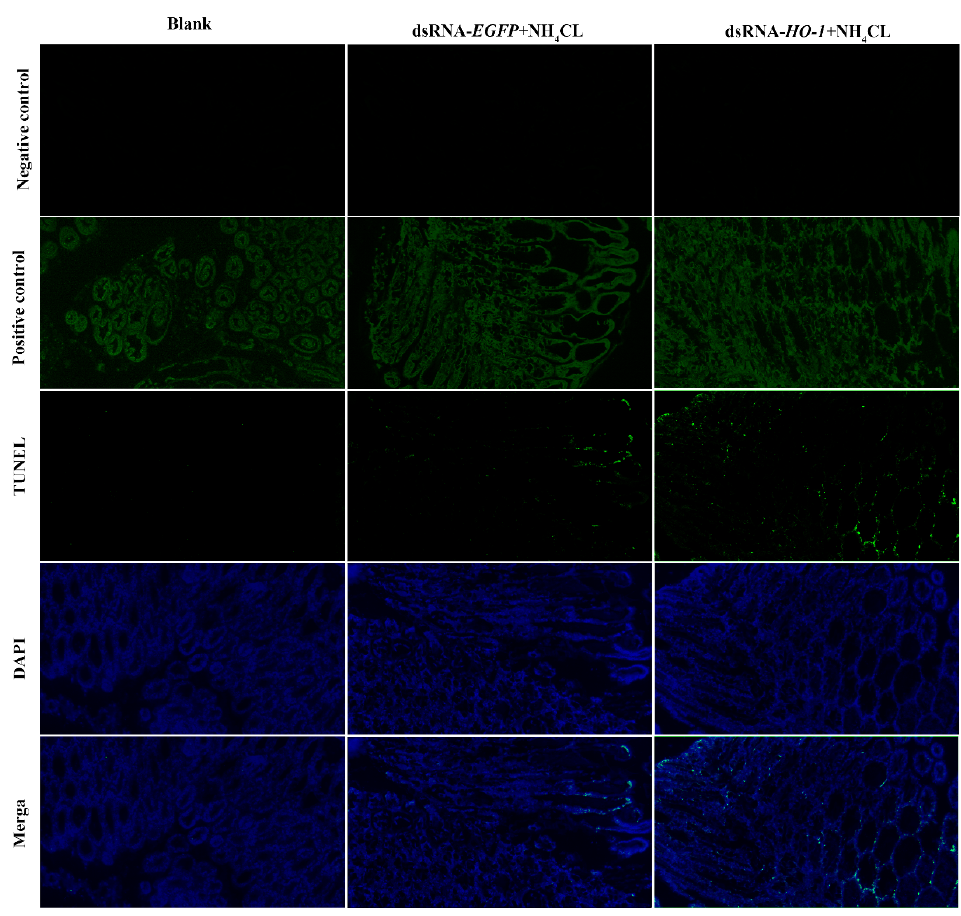
Figure 7. Apoptosis detection of intestine tissues of PBS group, dsRNA- EGFP +NH 4 CL group, and dsRNA- HO-1 +NH 4 CL group at 48 h post-challenge via TUNEL assay. Apoptosis signals are marked in green. Nuclei are marked in blue. All sections were observed at 50× magnification.